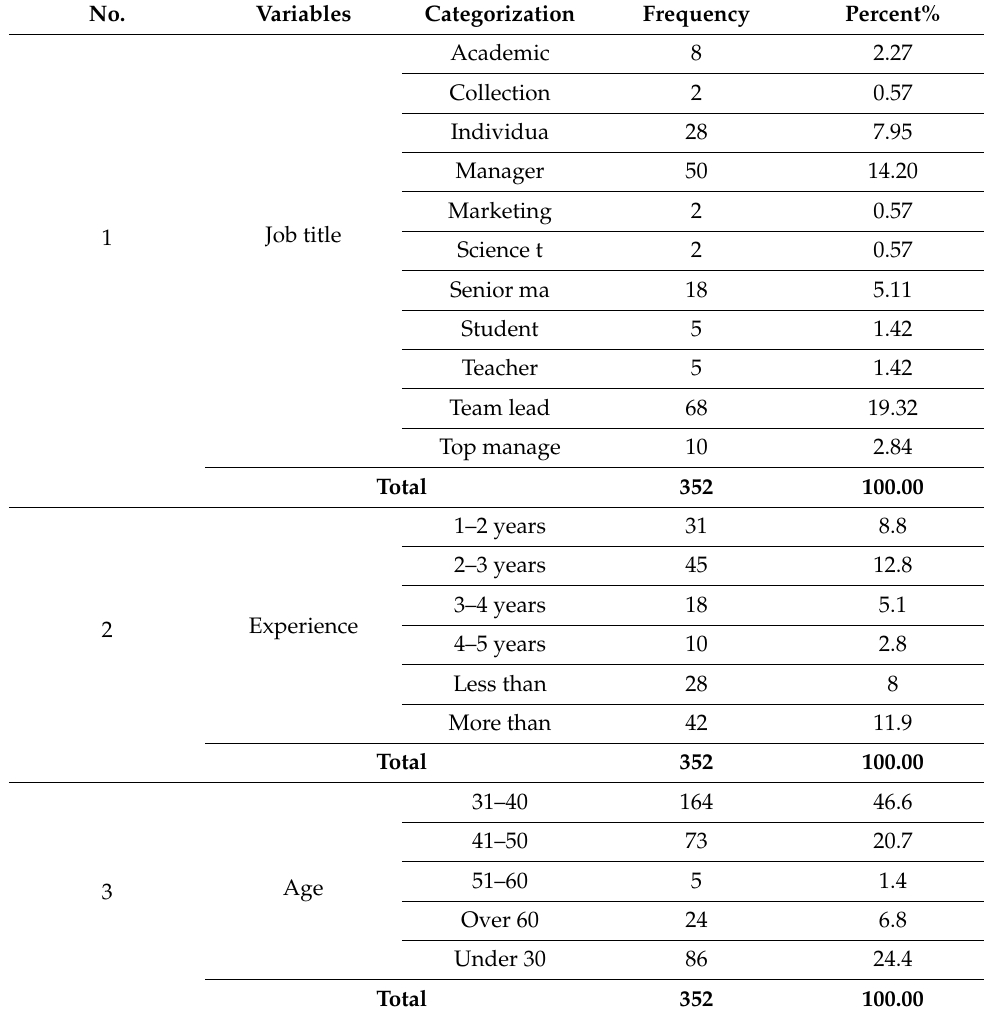
Table 1. Descriptive sample of the demographic variables of the study.